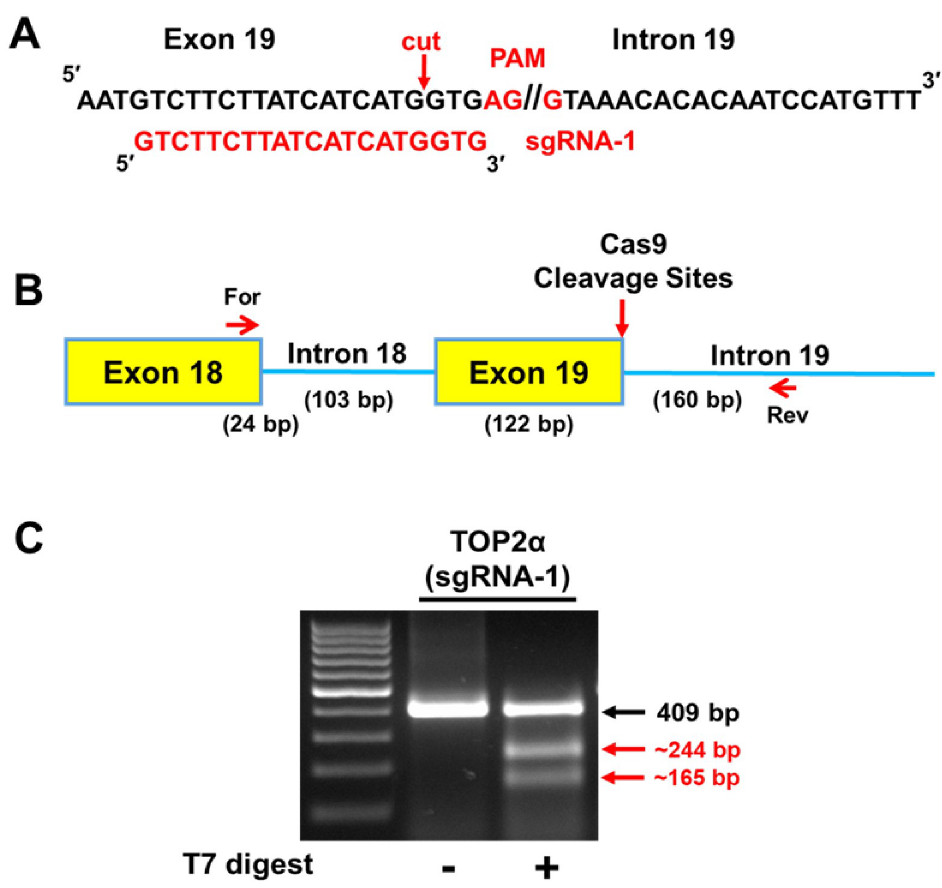
Fig 2. Assessment of sgRNA-1/Cas9 complex cleavage efficiency at the TOP2 α E19/I19 boundary sequence. (A) Sequence of the TOP2 α E19/I19 boundary is shown. PAM/sgRNA-1 site is shown in red. The red arrow denotes where Cas9 will generate a DSB. (B) Schematic representation of the E18 through I19 region of the TOP2 α gene. The larger red arrow denotes the site where sgRNA-1 directed Cas9 cleavage and NHEJ generation of INDELs can occur. The small red arrows denote the forward and reverse primers used for the GCD assay. (C) Ethidium bromide-stained agarose gel fractionated GCD PCR amplicons before and after treatment with T7 endonuclease I. The parental and T7 endonuclease I cleaved daughter PCR amplicons are indicated and their respective sizes are denoted.